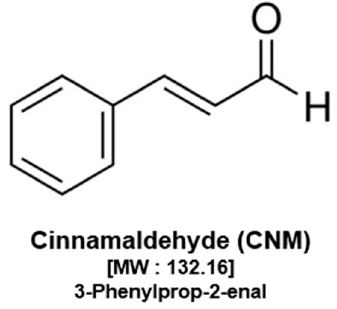
Figure 1. Molecular structure of cinnamaldehyde (CNM).